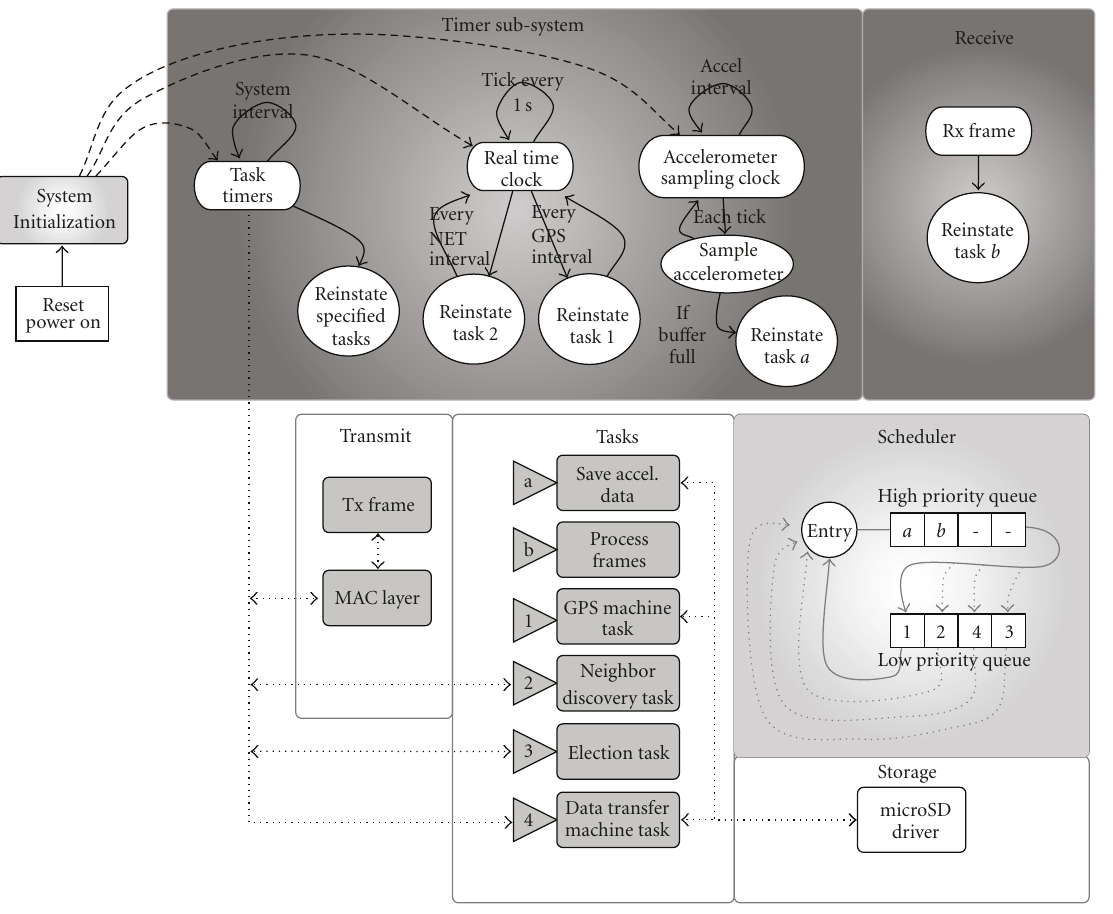
Figure 4: Top level block diagram of the CARNIVORE firmware.